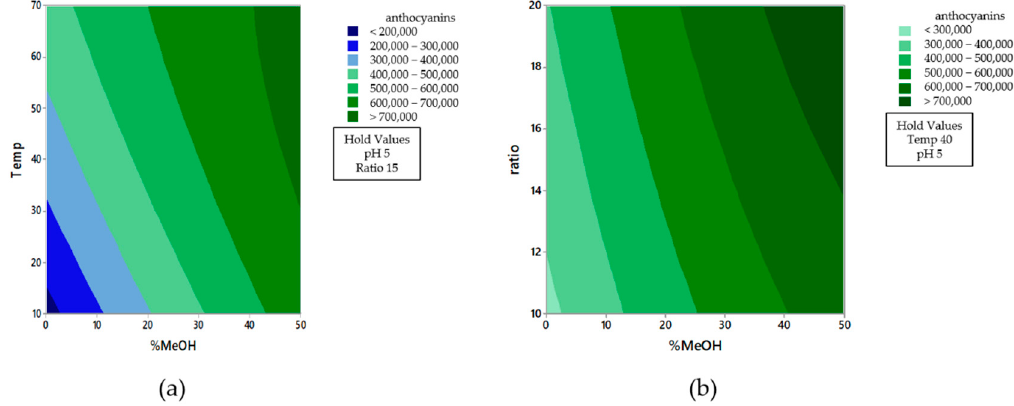
Figure 3. Contour plots of the effect from %MeOH vs. temperature ( a ) and %MeOH vs. ratio ( b ) on the recovery of anthocyanins.